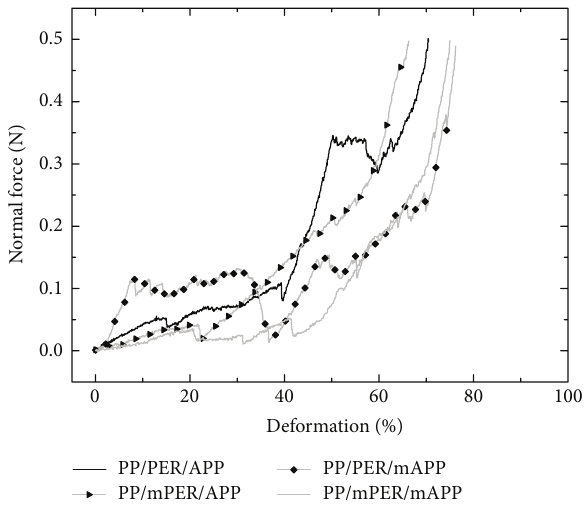
Figure 5: Compression test of charred foams obtained after com- bustion under cone